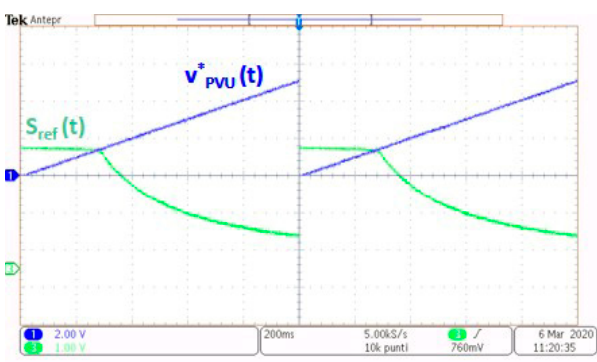
Figure 10. Oscilloscope screenshot ( S = 400 W / m 2 , T = 57.5 ◦ C, and V dsmax = 100 V). Figure 10. Oscilloscope screenshot ( 𝑆 = 400 W/m 2 , 𝑇 = 57.5 °C , and 𝑉 (cid:3031)(cid:3046)(cid:3040)(cid:3028)(cid:3051) = 100 V). Figure 10. Oscilloscope screenshot ( 𝑆 = 400 W/m 2 , 𝑇 = 57.5 °C , and 𝑉 (cid:3031)(cid:3046)(cid:3040)(cid:3028)(cid:3051) = 100 V).